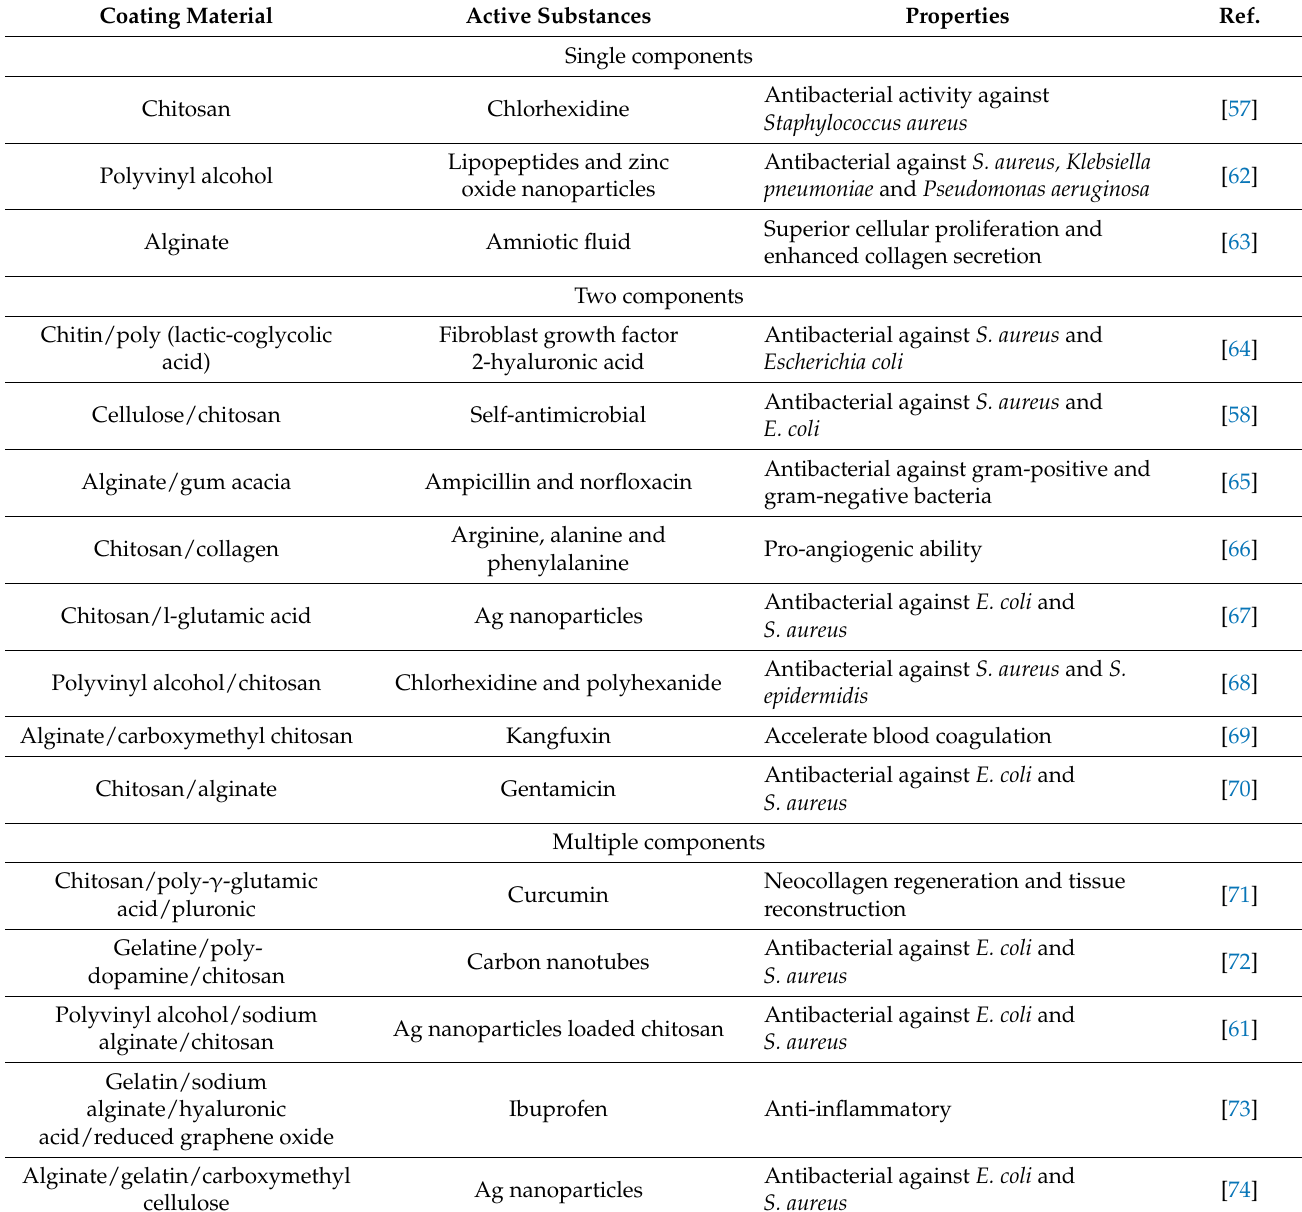
Table 2. Coating materials based on single and multiple support